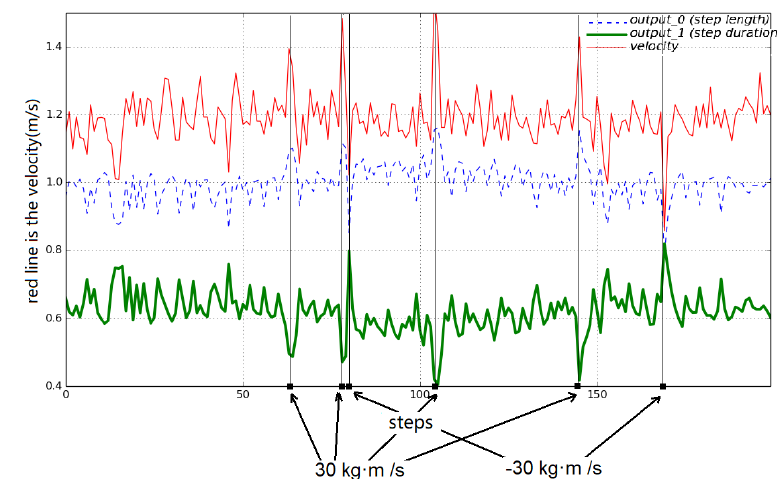
Figure 11. Deep deterministic policy gradient (DDPG) output over different speeds. The red line is the speed, and the green and blue lines are DDPG outputs, which are scaled and biased so that they can fit in the same graph for